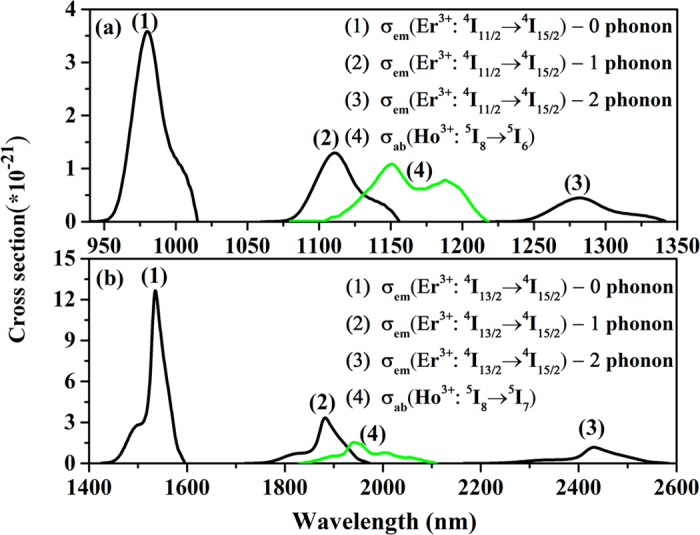
(a) Emission cross sections assisted by m (m = 0, 1 and 2) phonons for the Er3+:4I11/2→4I15/2 transition and absorption cross sections for the Ho3+:5I8→5I6 transition; (b) emission cross sections of the Er3+: 4I13/2→4I15/2 transition with the participation of m (m = 0, 1, and 2) phonons and absorption cross sections of the Ho3+: 5I8→5I7 transition in the silicate sample.